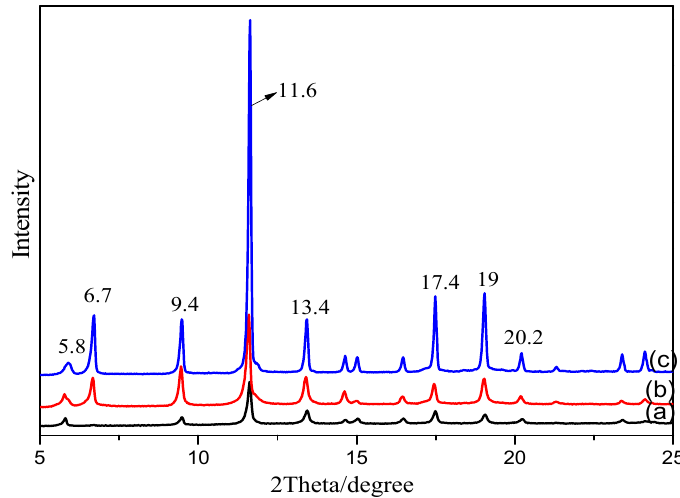
Figure 3. The X-ray diffraction (XRD) patterns of ( a ) Cu-BTC, ( b ) NH 2 -Cu-BTC and ( c ) sub-NH 2 -Cu-BTC.